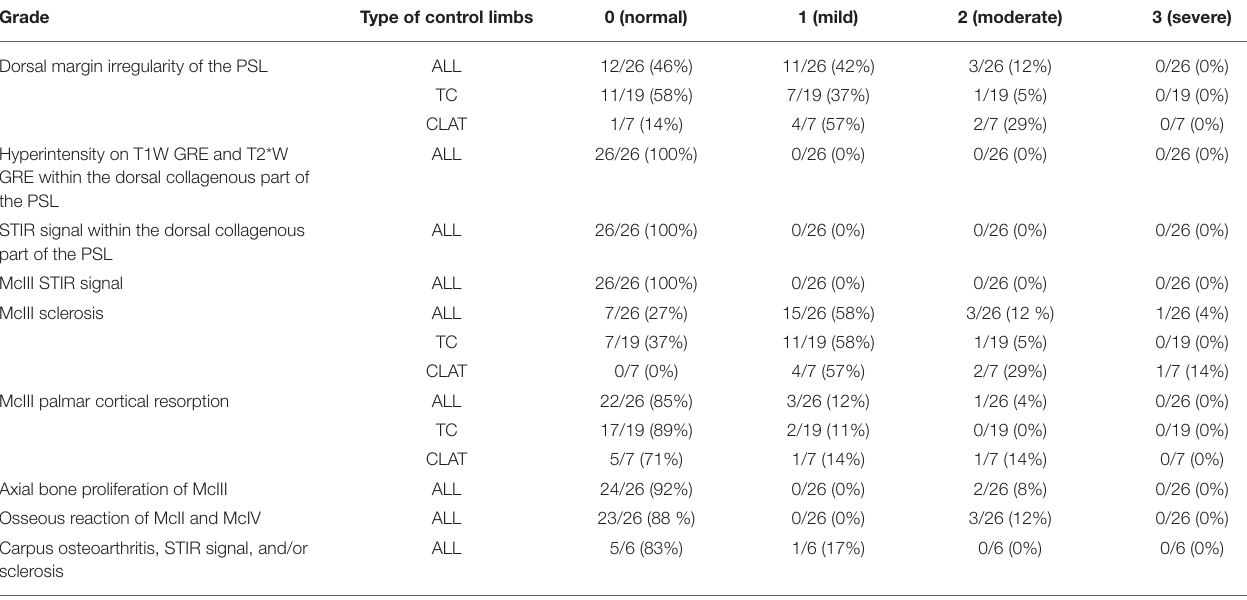
TABLE 2 | Grading of pathological findings per limb in control group identified using MRI. Grade Dorsal margin irregularity of the PSL